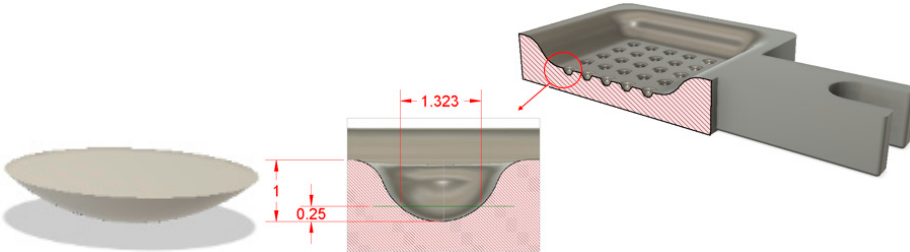
Figure 15. Theorical erosion semi sphere.